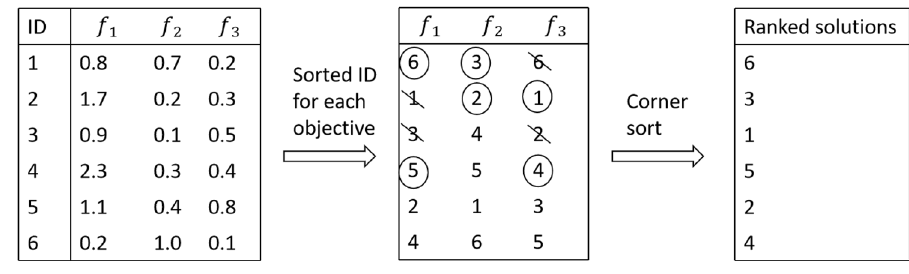
final sorted list, we have three solutions #6, #3, #1. Next we